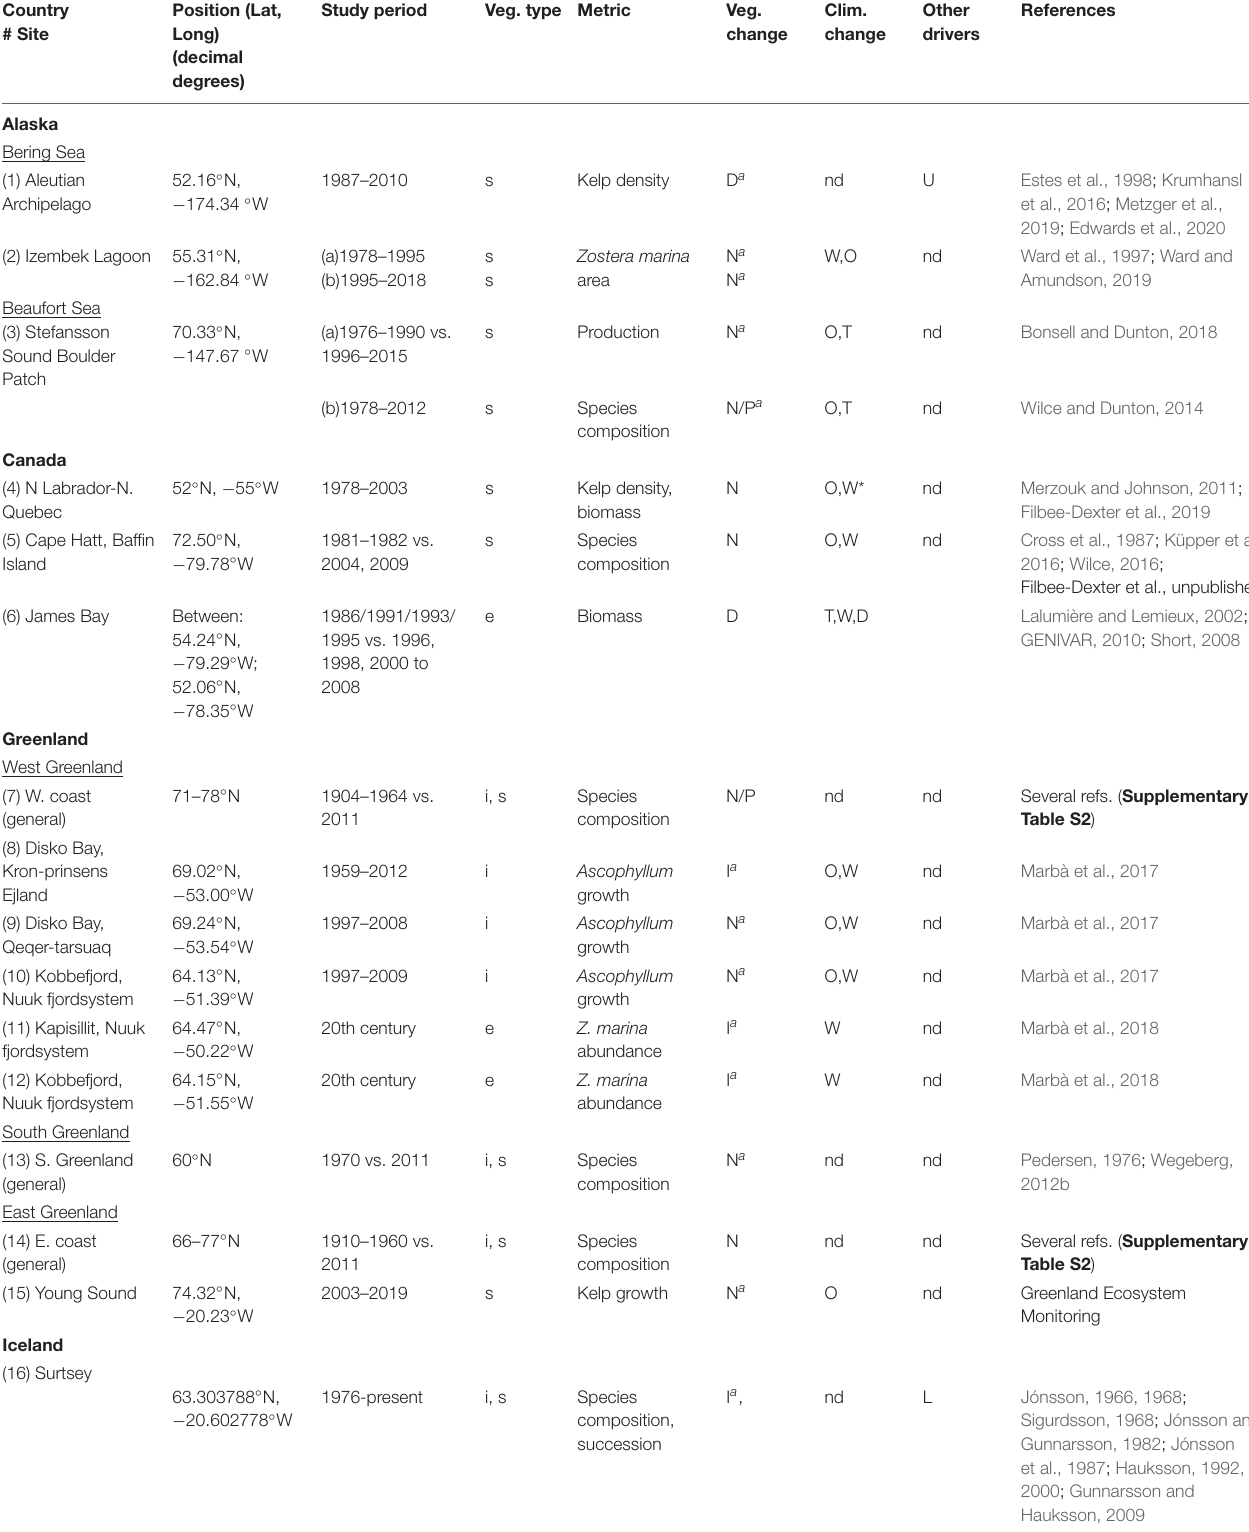
TABLE 1 | Overview of compiled timeseries for pan-Arctic marine vegetation spanning at least 10 years. Country #